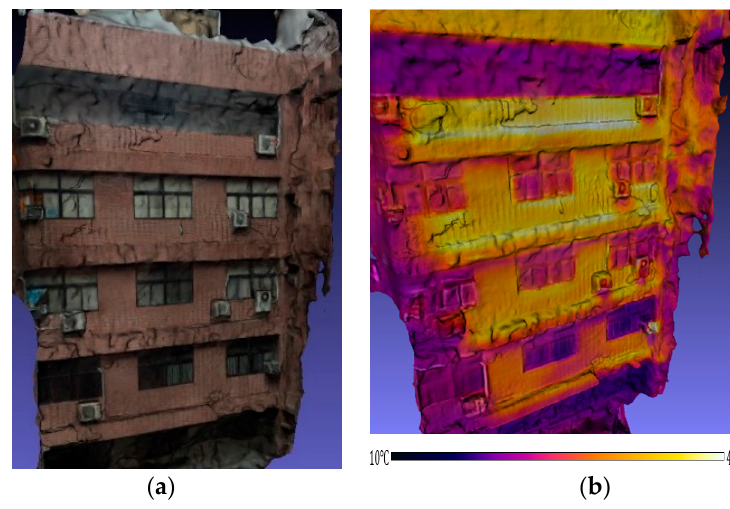
Figure 9. Model reconstruction of large scale scene: ( a ) 3D model of exterior wall of departmental building; ( b ) 3D thermal model of exterior wall of departmental building.